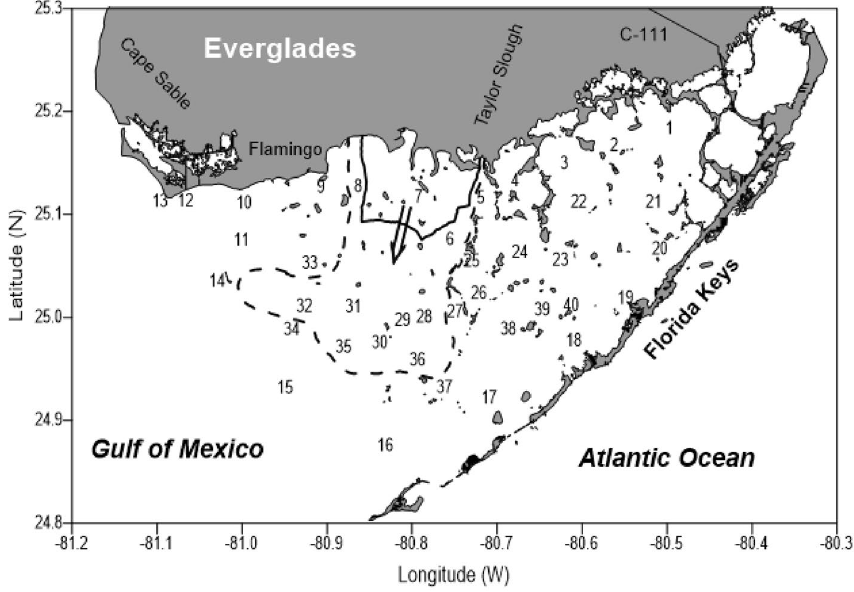
Figure 1. Locations of 40 sampling stations in Florida Bay. Seasonal progression of cyanobacteria bloom is indicated by the arrow and contour lines: summer in solid line and fall in dash line (after Phlips et al. 29